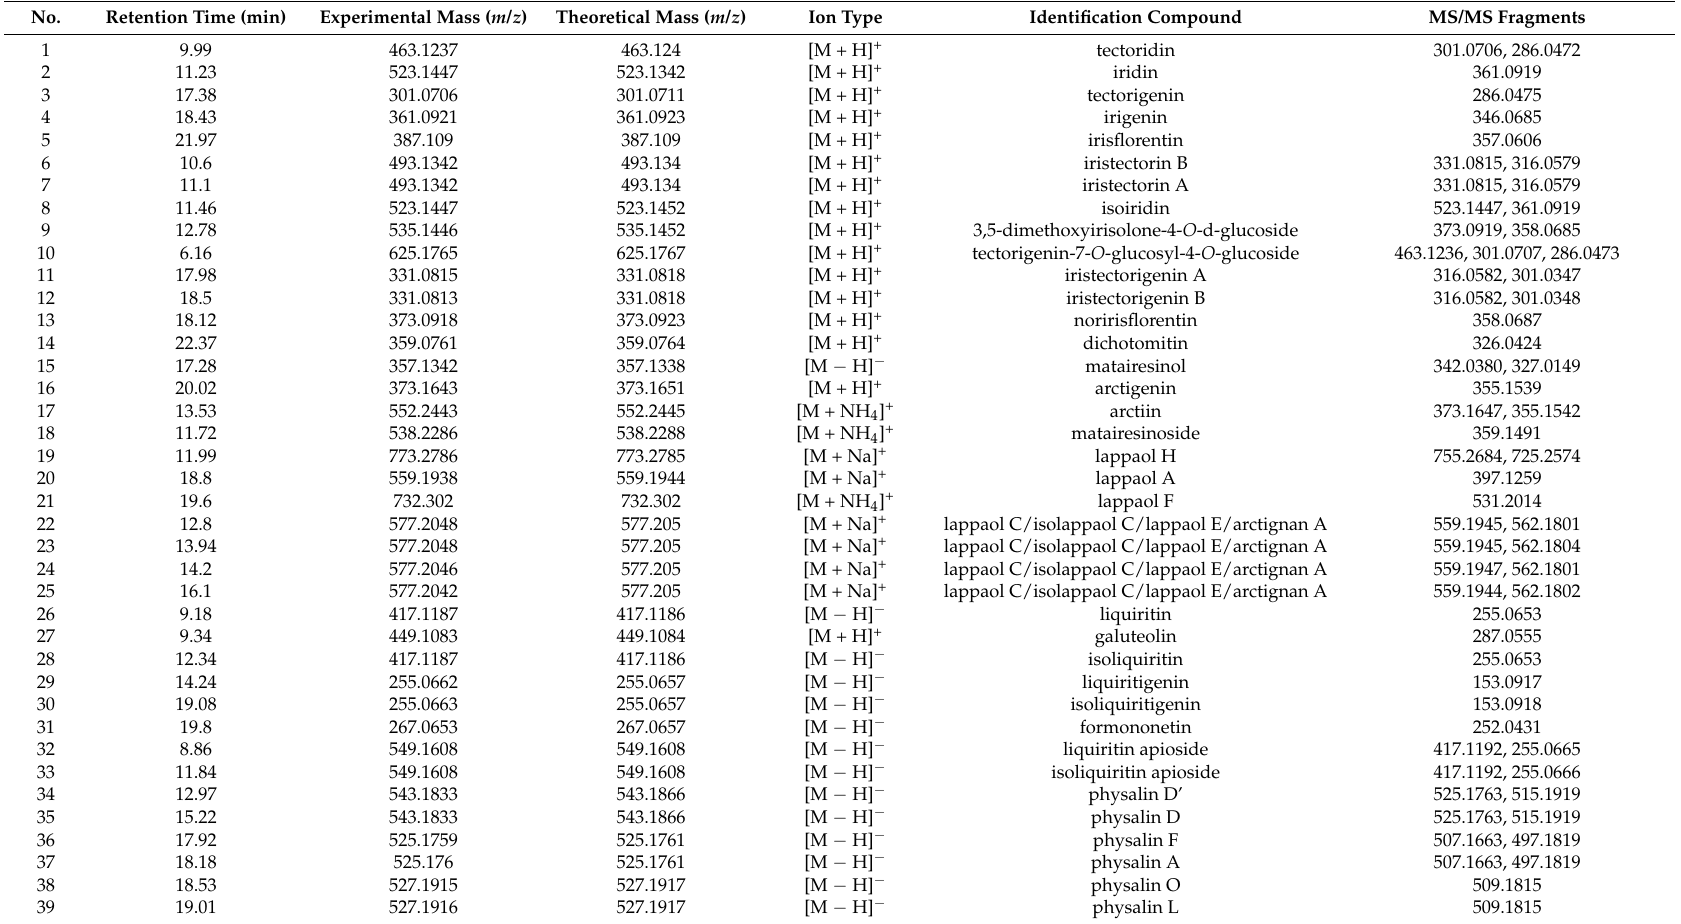
Table 1. Identified compounds of Shejin-liyan Granule by HPLC-LTQ-Orbitrap